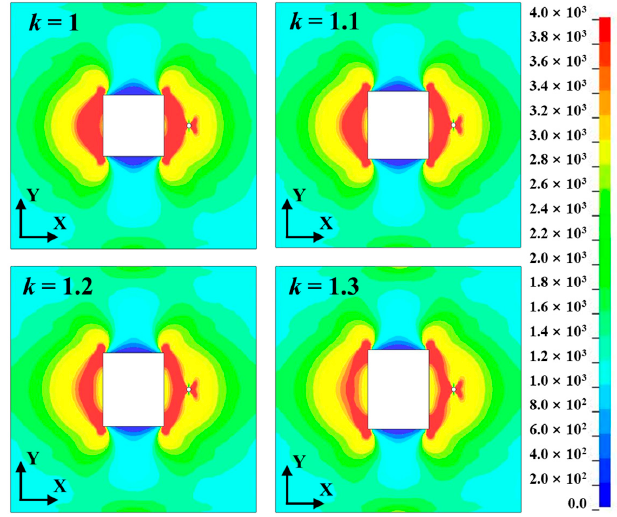
Figure 14. Strain energy density with different k under P1 = 5 MPa and P2 = 10 MPa. Table 4. The crater volumes under different k .